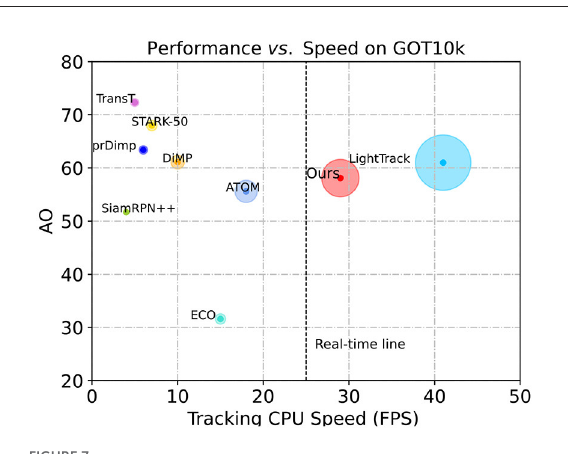
FIGURE7 Speed and performance comparisions on GOT-10k. The horizontal axis represents model speed on a CPU and the vertical axis represents the AO